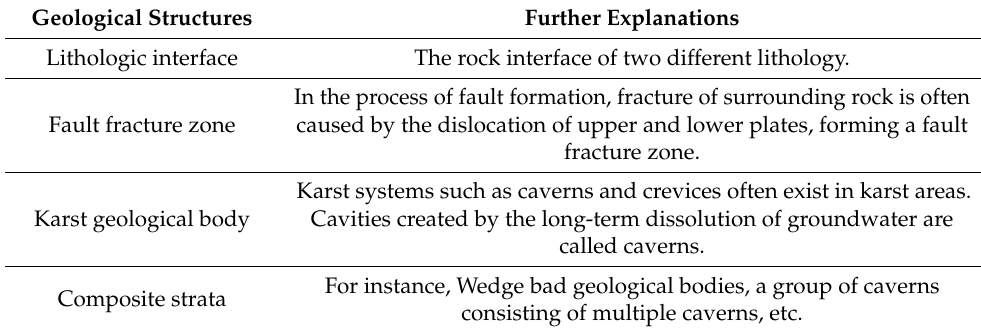
Table 1. The explanations of undesirable geological structures in tunnels.